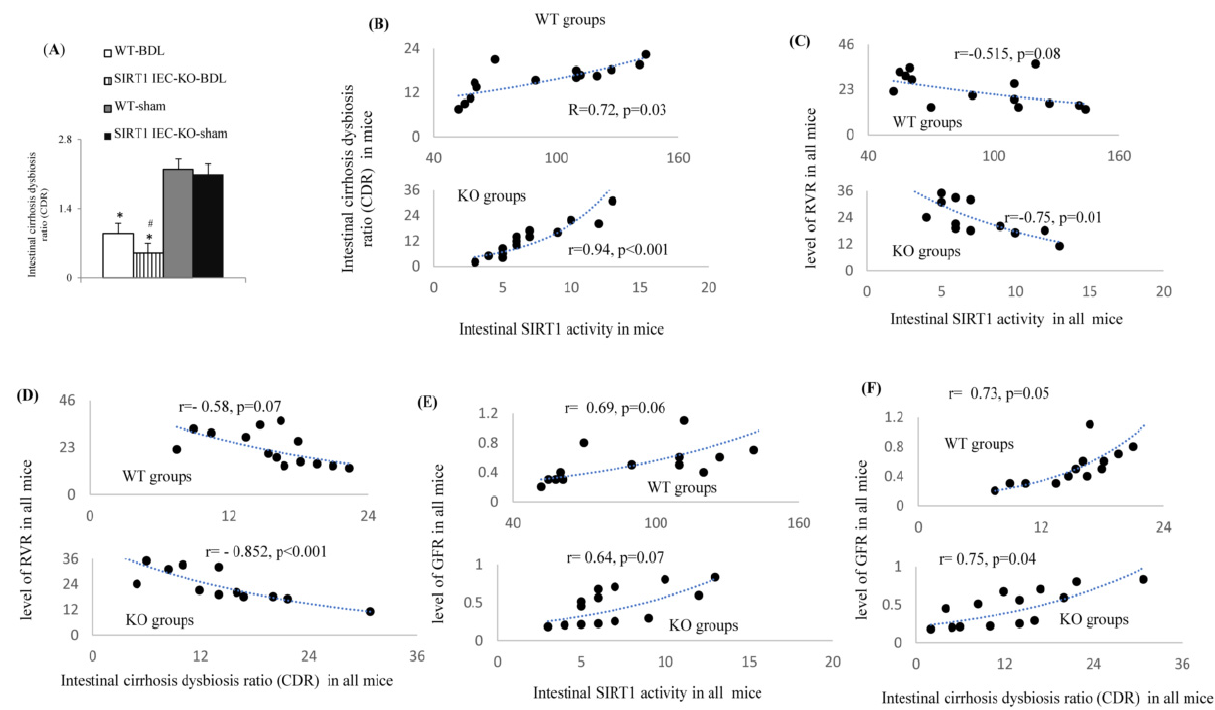
Figure 10. Relationship between various intestinal/renal pathogenic markers with cirrhosis discrimination ratio (CDR). ( A ) The data of CDR between groups; ( B ) correlation between intestinal SIRT1 activity and the CDR in WT and KO mice groups; * vs. WT-sham mice; # vs. WT-BDL mice; ( C ) correlation between intestinal SIRT1 activity and the RVR (renal vascular resistance) in WT and KO mice groups; ( D ) correlation between the CDR and the RVR in WT and KO mice groups; ( E ) correlation between intestinal SIRT1 activity and the GFR (glomerular filtration rate) in WT and KO mice groups; ( F ) correlation between the CDR and the GFR. WT mice groups include WT-BDL and WT-sham mice; KO mice groups include the SITR1 IEC-KO -sham and SITR1 IEC-KO -BDL mice. Mn/CuZn-SOD: superoxide dismutase; p-MLCK/MLCK: phosphorylated myosin light chain kinase; ZO-1: zonula occludens-1, TNFR1/TNFR2; tumor necrosis factor receptor 1 and 2; KIM; kidney injury marker.